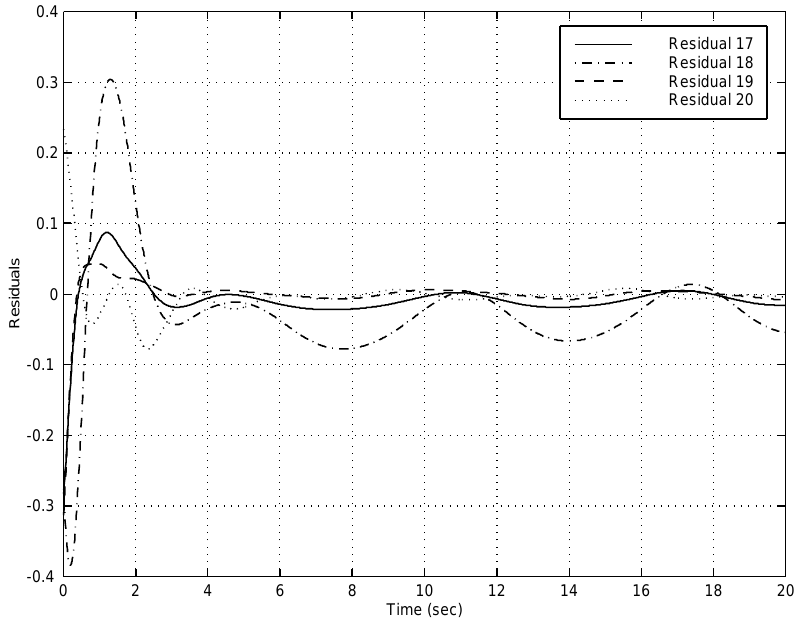
Fig. 9. Residuals 17–20 for 16 mode simulation with δ 1 = 0 . 005 .